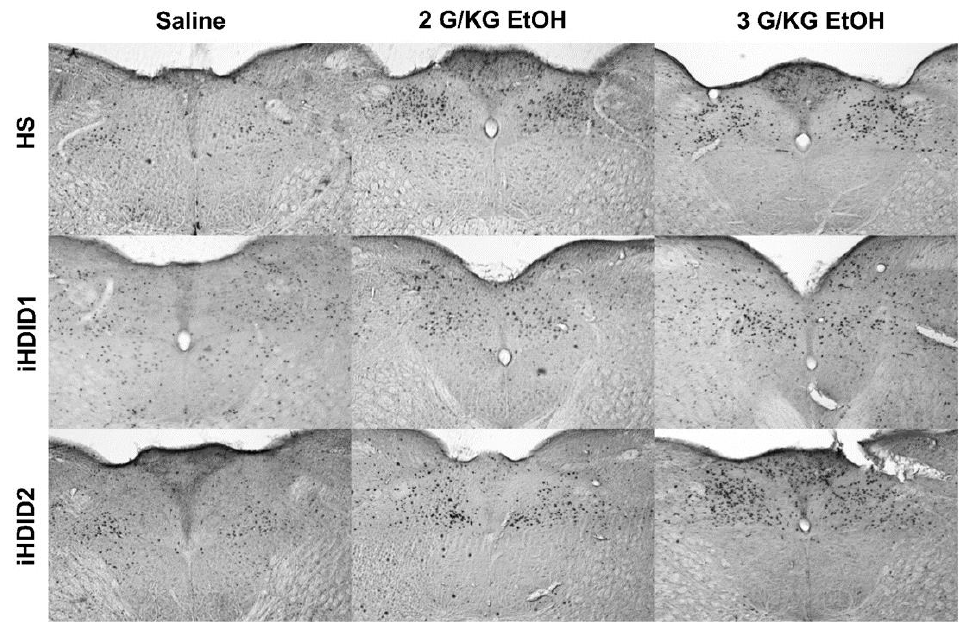
Figure 2. A2 Region of the Solitary Tract Nucleus. Representative images of c-Fos expression in the A2 across genotype and treatment types.